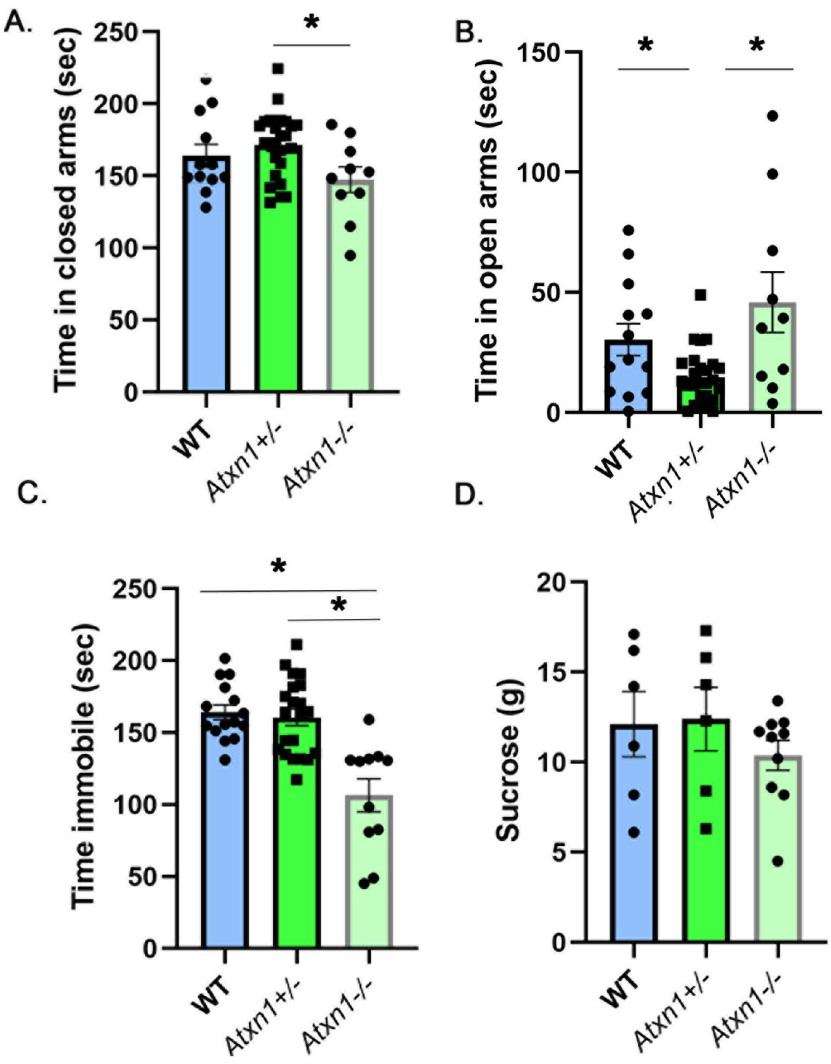
Figure 5. Decreased immobility in homozygous ( Atxn1 −/ − ) and increased anxiety in heterozygous ( Atxn1 + /- ) mice. 8–10 weeks old wild-type, Atxn1 + /− , and Atxn1 −/ − mice were tested on the Elevated Plus Maze, Forced Swim Test and Sucrose preference test. ( A ) Time in closed arms. ( B ) Time in open arms. ( C ) Time spent immobile. ( D ) Amount of sucrose consumed. * indicates P < 0.05 using the One way ANOVA followed by post- hoc Tukey’s testing, data are presented as mean ±